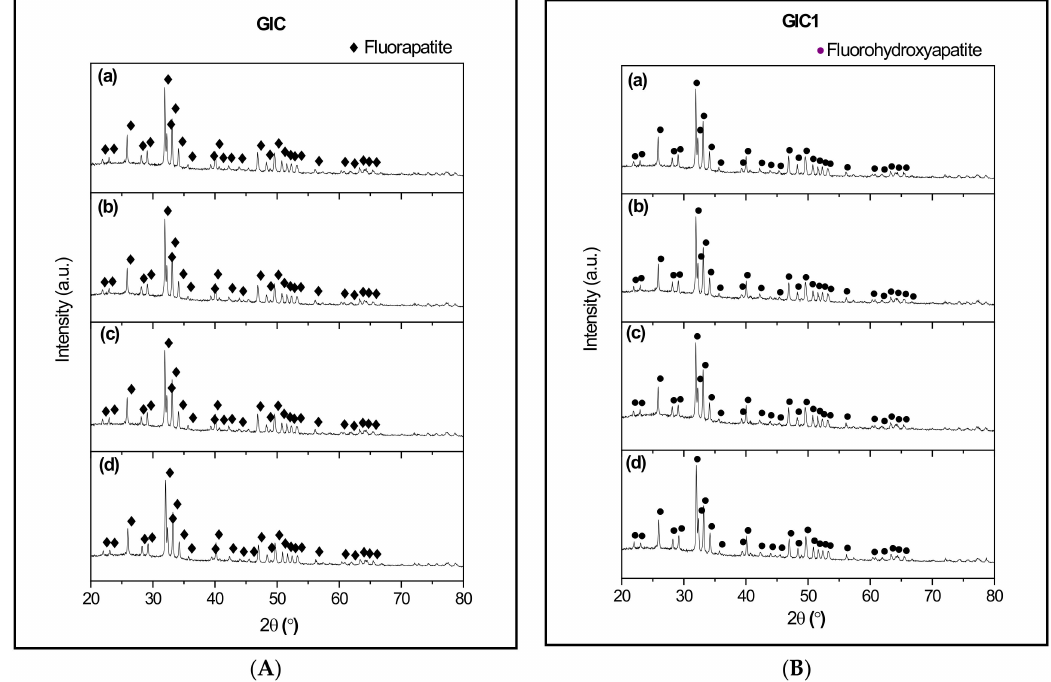
Figure 3. XRD patterns of GIC ( A ) and GIC1 ( B ) sample with (a) 1 day, (b) 7 days, (c) 14 days, and (d) 21 days of ageing time.